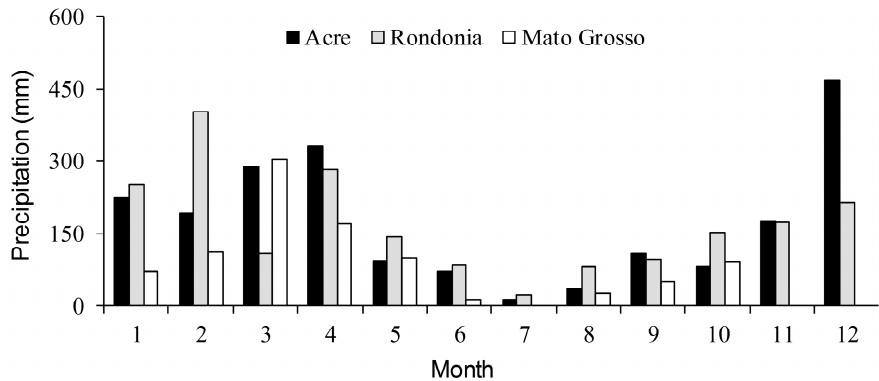
Figure 9. Monthly precipitation across study sites in 2009 from INMET. Note: Precipitation data from July, November, and December for Mato Grosso are missing.